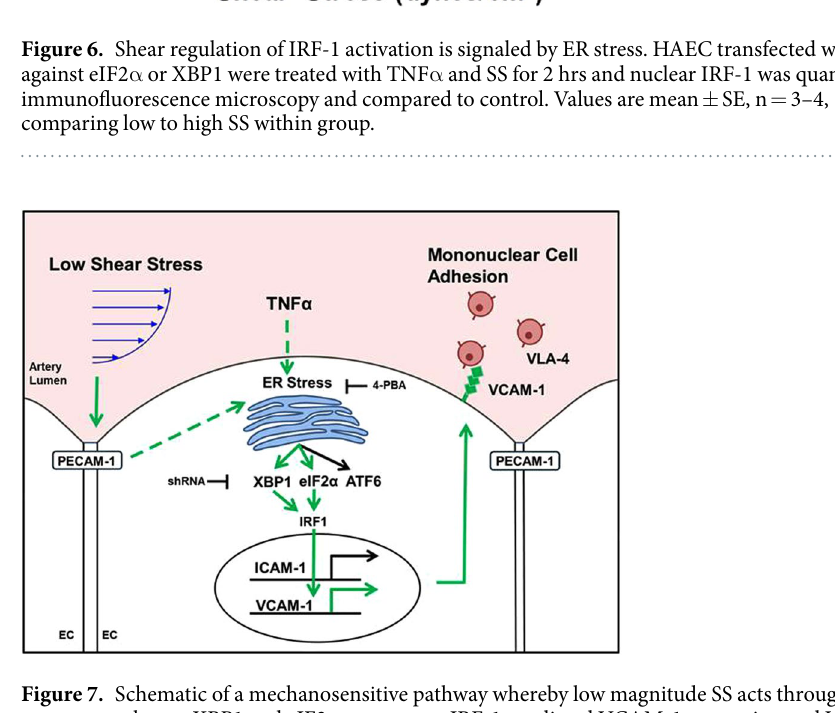
Figure 7. Schematic of a mechanosensitive pathway whereby low magnitude SS acts through the ER stress response pathways XBP1 and eIF2 α to promote IRF-1-mediated VCAM-1 expression and VLA-4-dependent monocyte